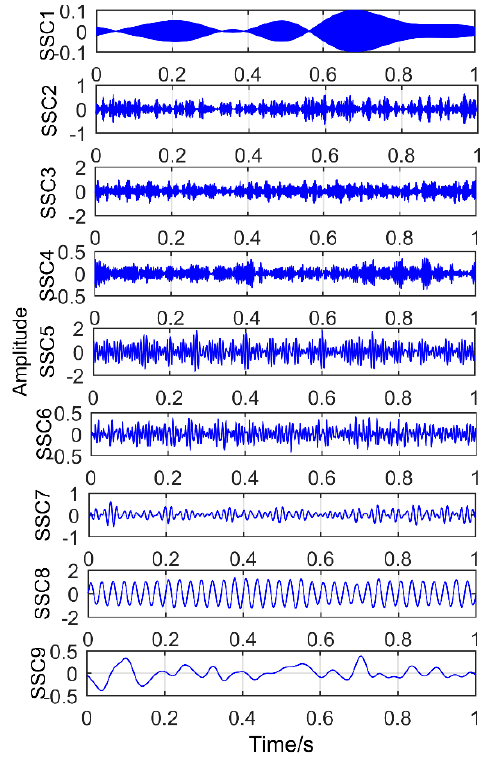
Figure 17. The decomposition results obtained by SSD.